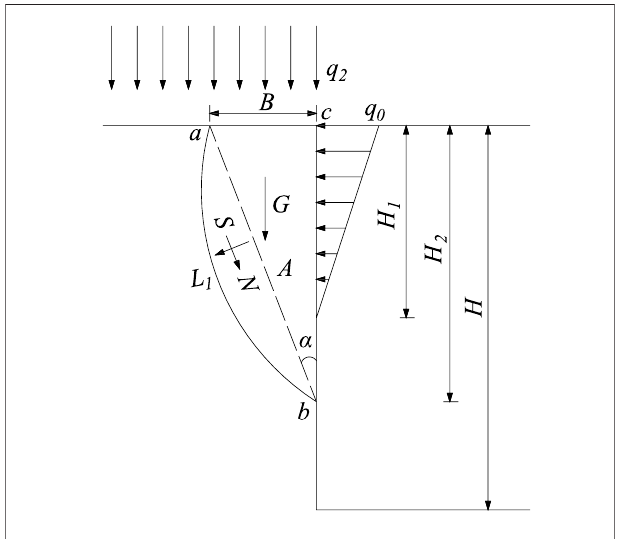
FIGURE 5 | Shear failure model of coal wall (Kong et al., 2017).